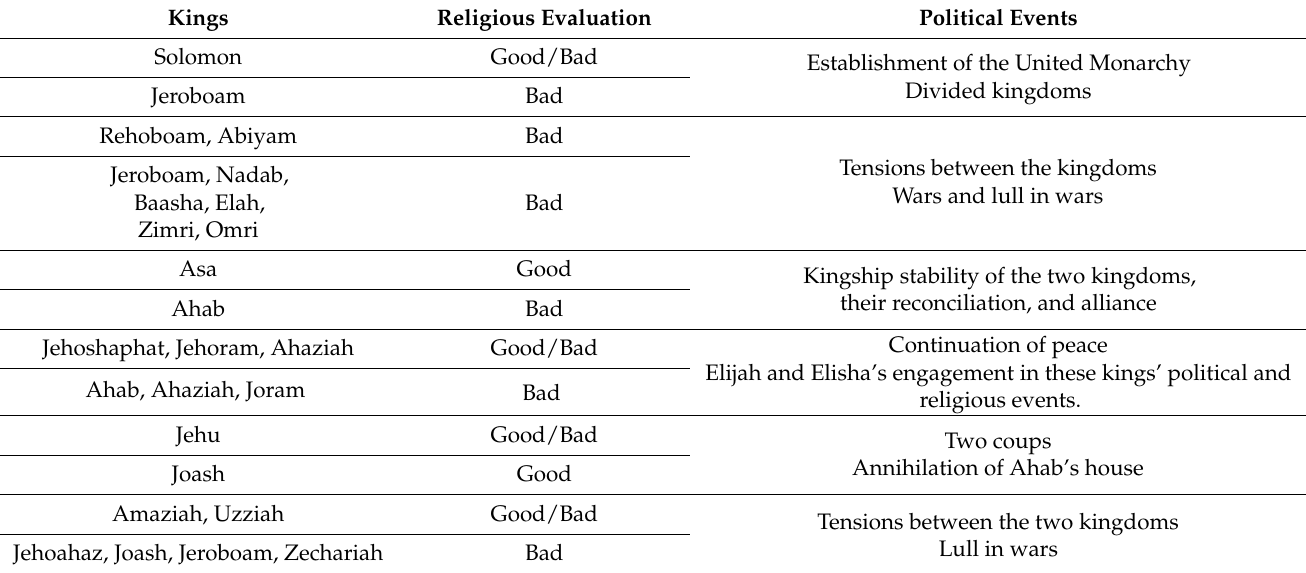
Table 1. Religious evaluation in light of